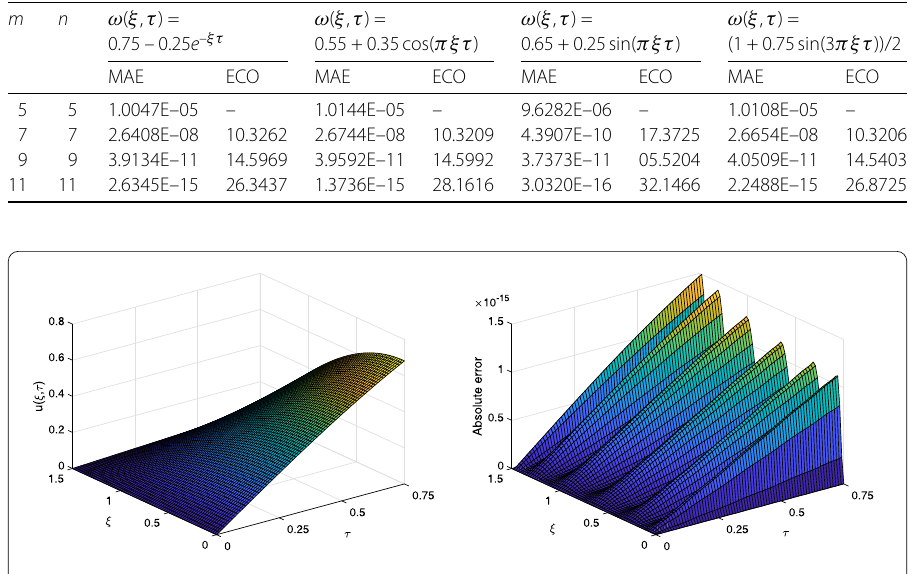
Figure 6 Numerical results for Example 4 with ω ( ξ , τ ) = 0.75 – 0.25 e – ξτ and ( m = 12, n =